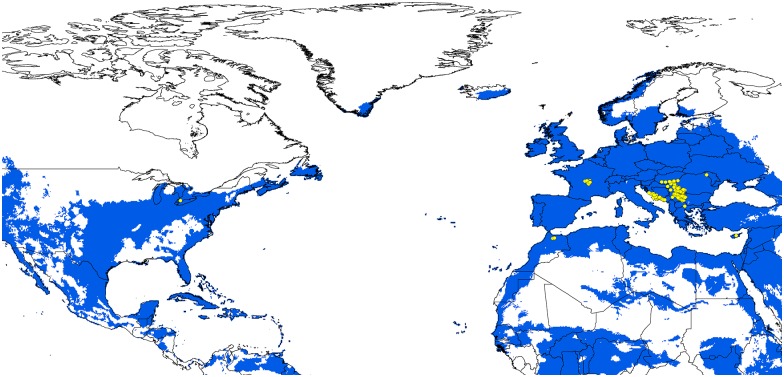
Relationship of additional independent BTV records to areas predicted as suitable for bluetongue virus occurrences.Yellow points are independent BTV occurrence data from the Old World and North America. Blue areas are represented as suitable and white as unsuitable.